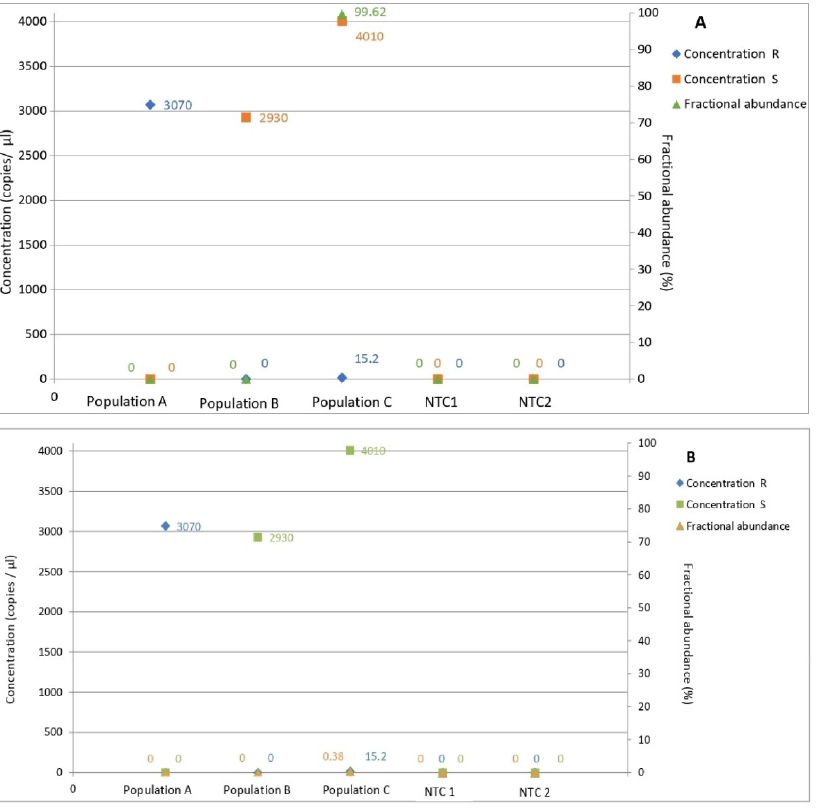
Figure 5. Determination of copy number and fractional abundance of A143 and G143 alleles in three field populations of Z. tritici . A143 and G143 alleles are named in the graphic as R and S, respectively, and their copy numbers are represented by blue and green squares. ( A ) Orange diamonds represent the fractional abundances of G143 allele. ( B ) Orange diamonds represent the fractional abundances of A143 allele. Results for no-template control replications are shown in NTC1 and NTC2. When the output of the ddPCR analysis of population C was plotted on a 2D plot, each droplet sorted into one of four orthogonally arranged clusters, as expected for spe- cific probes (Figure 6).